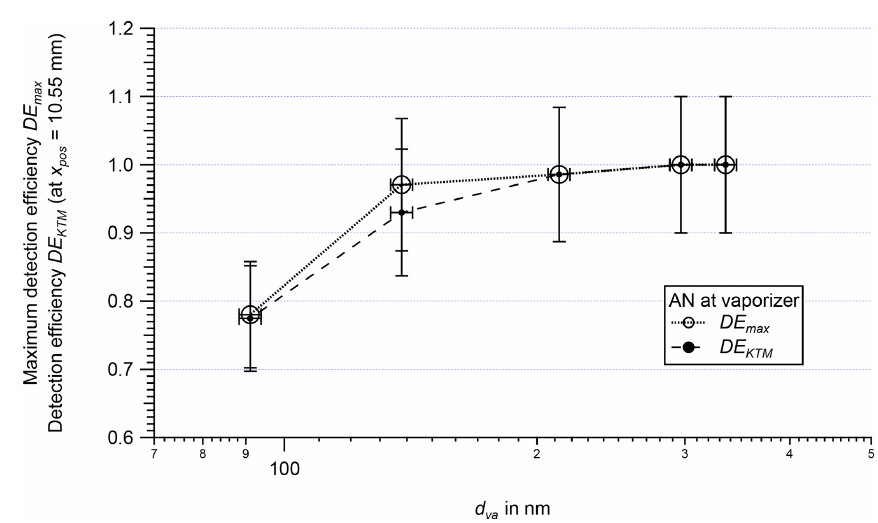
Figure 12. Maximum detection efficiency DE max (non-filled markers) and the detection efficiency DE KTM (filled markers; ADL setting during field deployment in Kathmandu, Nepal) as a function of particle size d va experimentally determined for AN particles measured at the ERICA-AMS vaporizer. The d 50 values of the AMS measurement lie outside the applied particle range. The uncertainties in DE max and DE KTM reflect the conservatively estimated value of